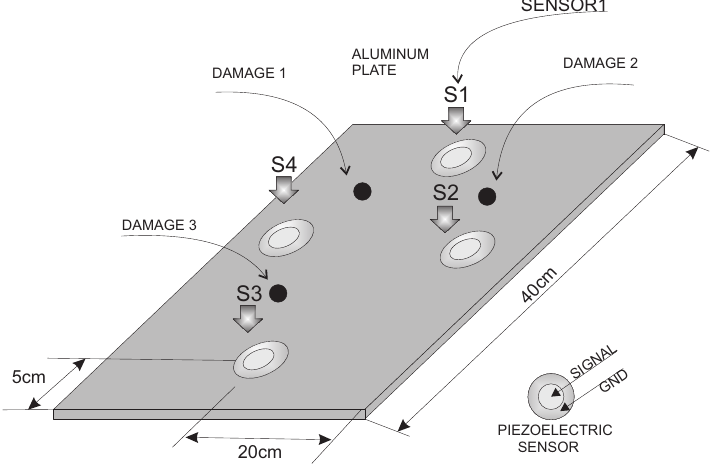
Figure 23. Aluminum plate instrumented with four piezoelectric